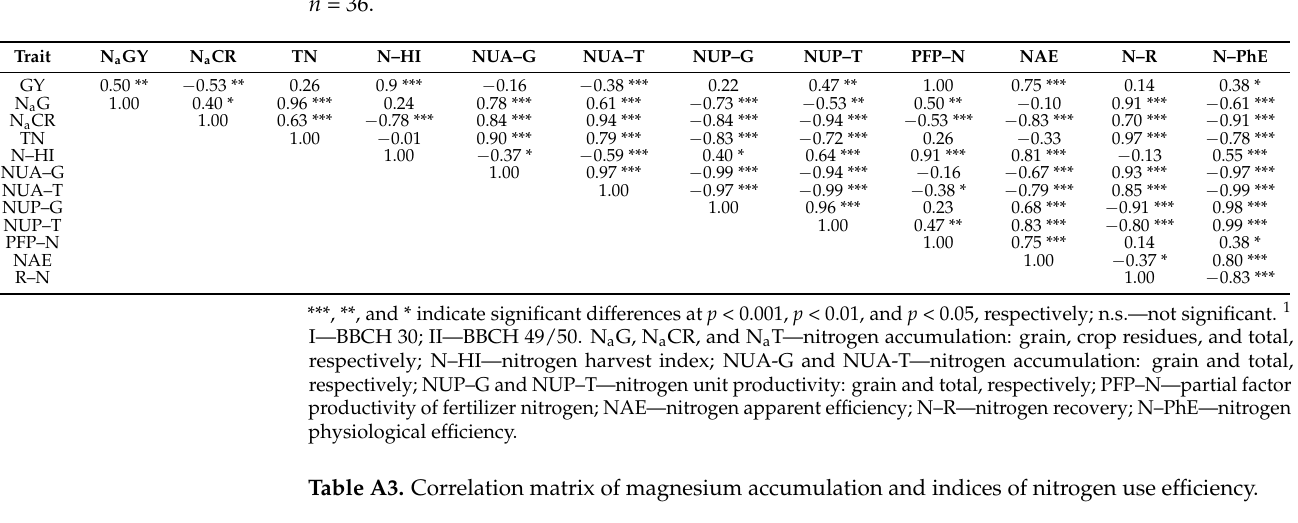
Table A2. Matrix of the correlation indices for nitrogen accumulation, efficiency indices, and yield, n = 36.